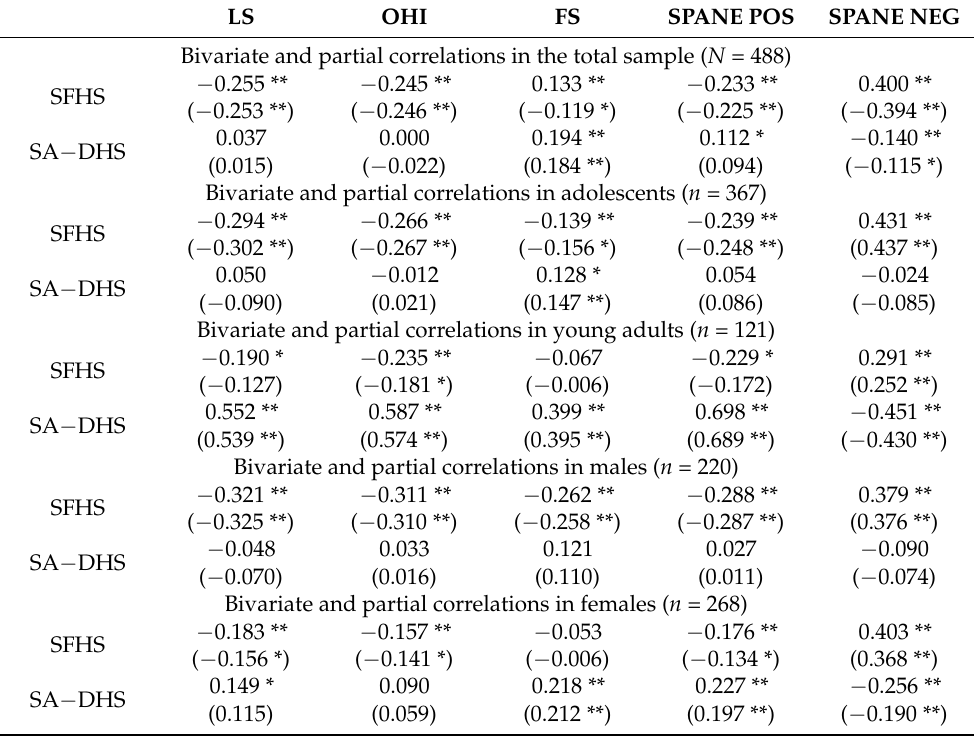
Table 6. Zero-order and partial correlations of the Subjective Authentic–Durable Happiness Scale and the Subjective Fluctuating Happiness Scale with well-being and happiness measures in Sample